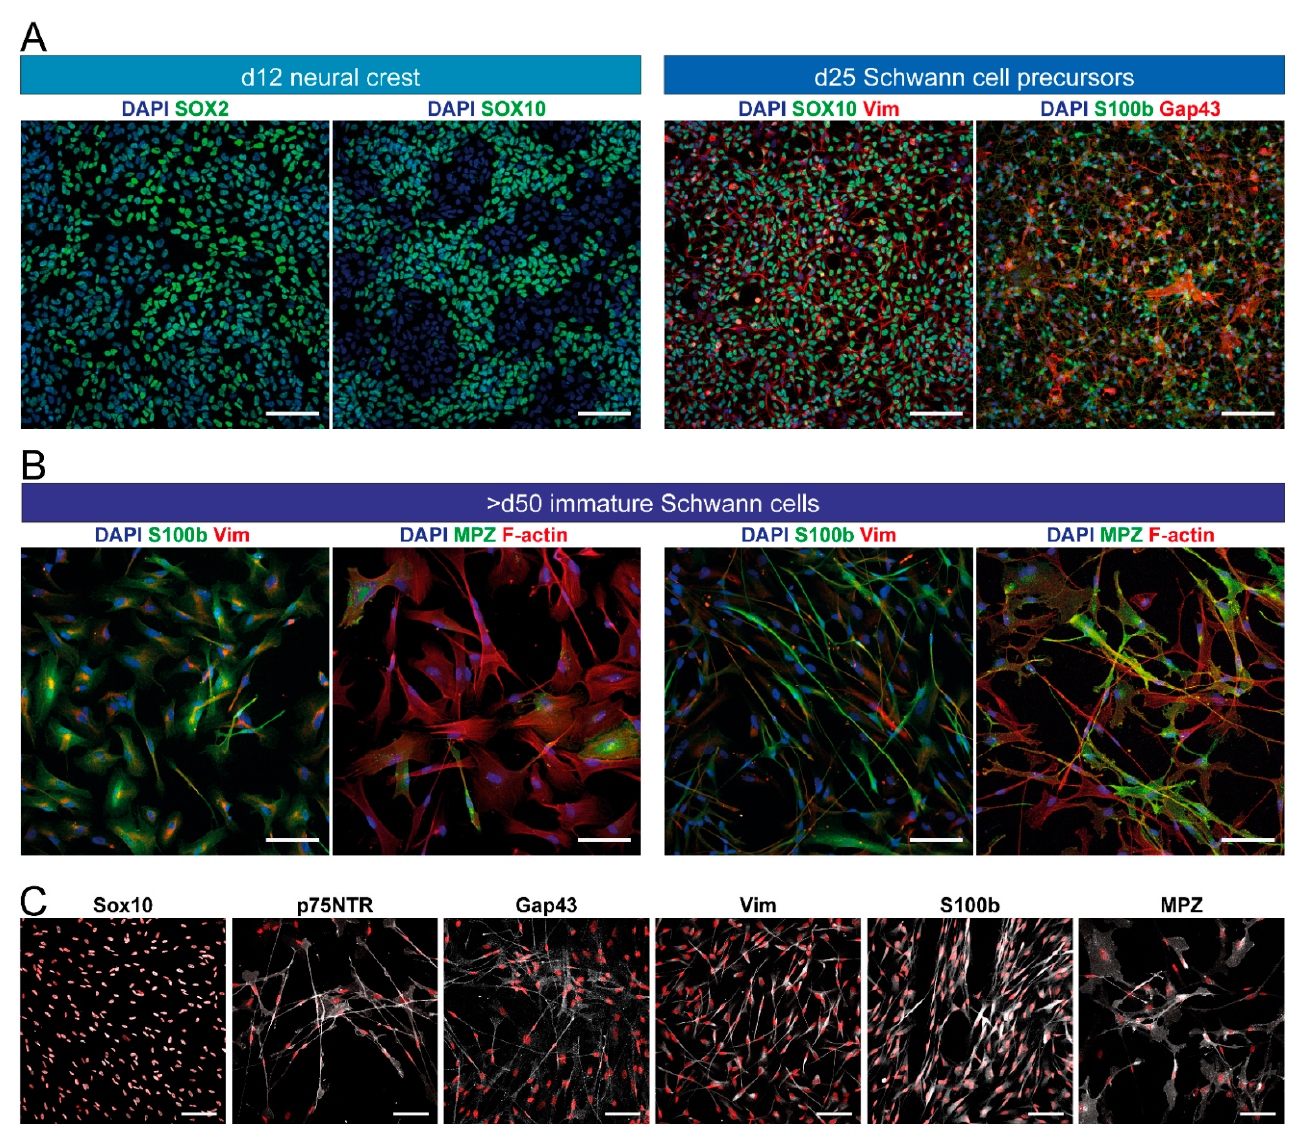
Figure 5. Expression of marker proteins by hiPSC-derived Schwann cells for several stages of differentiation. ( A – C ) Cells were differentiated according to the protocol presented by Hörner et al. 2021 [118], which is depicted in Figure 4. Representative immunofluorescence images of cells stained for different marker proteins (indicated) during the differentiation phase (d12; d25) and the maturation phase (>d50). All microscopy images were obtained from our own work; parts of the figure were adapted with modifications from Hörner et al. 2021 [118] under CC BY 4.0 license. ( A ) Representative marker protein signals at the neural crest stage (d12) and Schwann cell precursor stage (d25). Timepoints of fixation and color codes for immunofluorescence signals are indicated at the top of panels. Vim = vimentin. Scale bars, 100 µm. ( B ) Representative marker protein signals of cells differentiated for more than 50 days in the expansion phase (left two panels) and the matura- tion phase (right two panels) of the protocol. Color codes for immunofluorescence signals are indi- cated at the top of panels. Scale bars, 100 µm. ( C ) Immunofluorescence images of single marker proteins, as indicated at the top of panels, to show marker distribution in differentiated Schwann cells after the maturation phase. Immunofluorescence signals are shown in greyscale. Cell nuclei were labeled with DAPI and are shown in red. Scale bars, 100 µm.